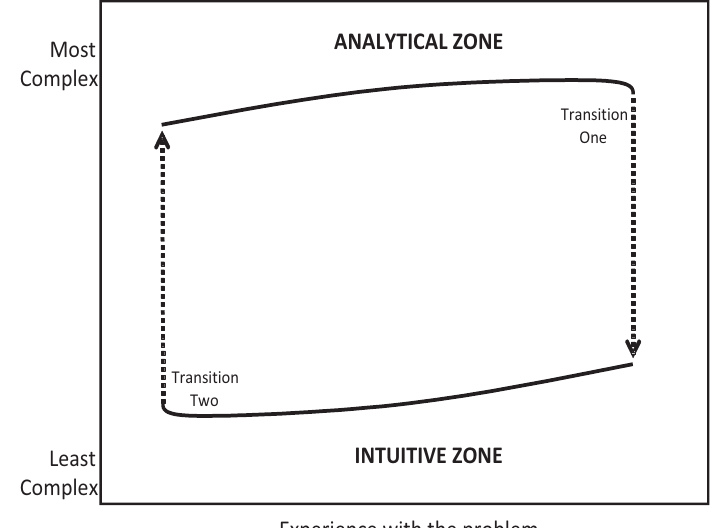
Figure 5. Zone map comparing complexity of the conceptual model versus experience.